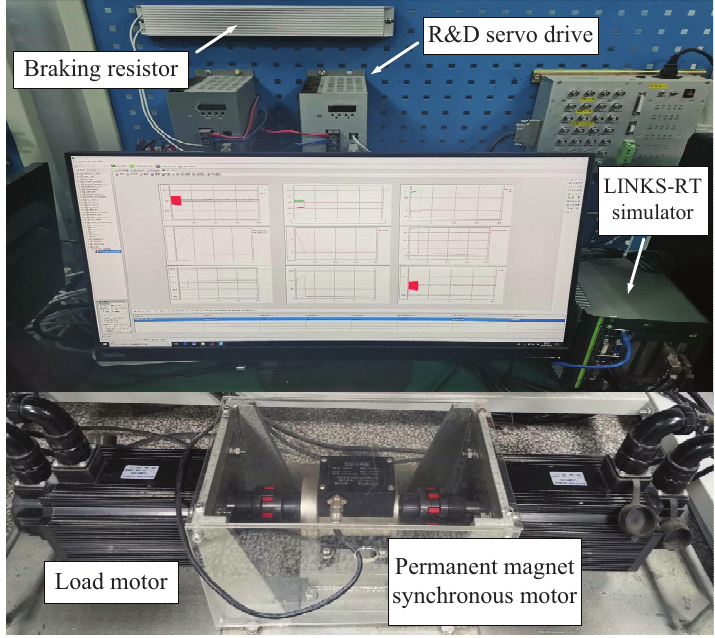
Figure 11. Experimental configuration of PMSM system.